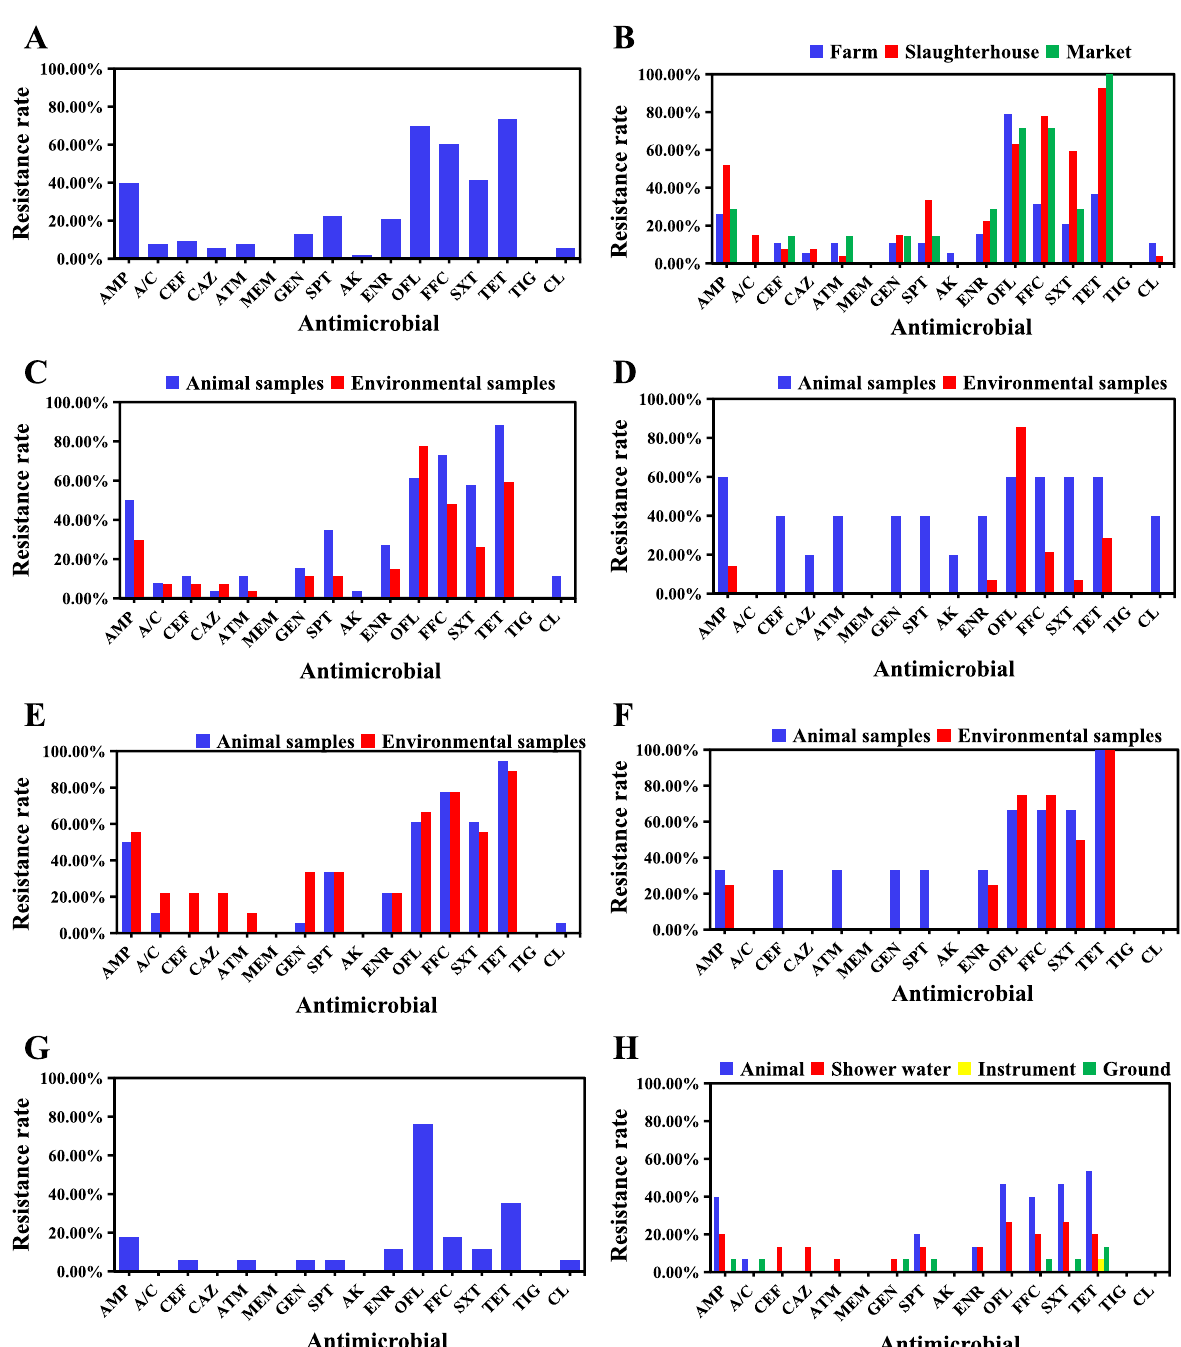
Fig. 2 Antimicrobial resistance rates of Salmonella isolates. A The overall antimicrobial resistance rates of 53 Salmonella strains isolated from the chicken production chain in Hubei Province, China. B The antimicrobial resistance rates of Salmonella isolated from different links. C The overall antimicrobial resistance rates of Salmonella isolated in different sample sources. D, E, F Antimicrobial resistance rates of Salmonella isolated from animal and environmental samples in farms ( D ), slaughterhouses ( E ), and retail markets ( F ). G Resistance rates of Salmonella Meleagridis. H Resistance rates of Salmonella isolated in WYS